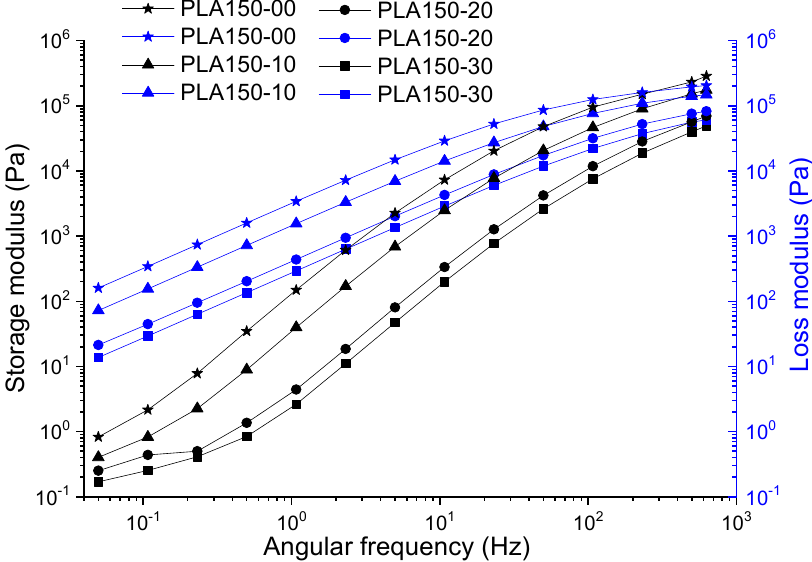
Figure 3. Storage and loss modulus of PLA and PLA with ATBC at 10, 20 and 30% extruded to 150 rpm.